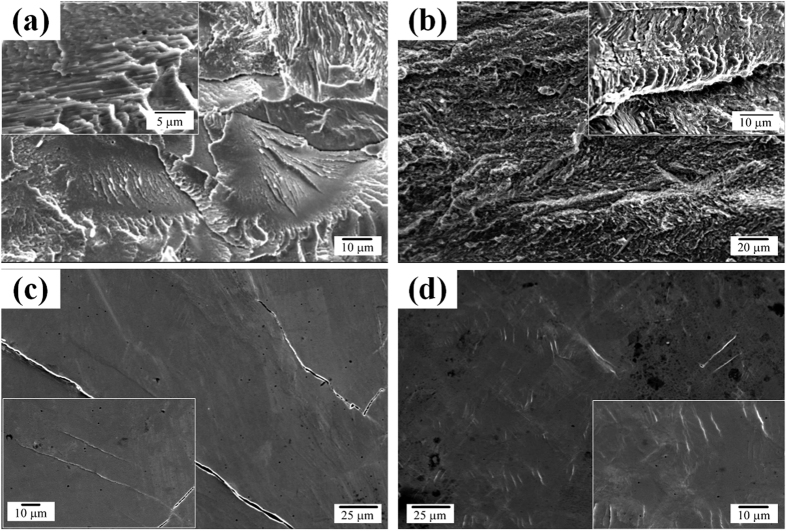
SEM secondary electron images of fracture/lateral surface obtained from the fractured Co65−xCr13Mo22Cux alloys with x = 0 and 0.5 at.% alloys: (a) fracture surface and (c) lateral surface of x = 0 at.%, (b) fracture surface and (d) lateral surface of x = 0.5 at.%.